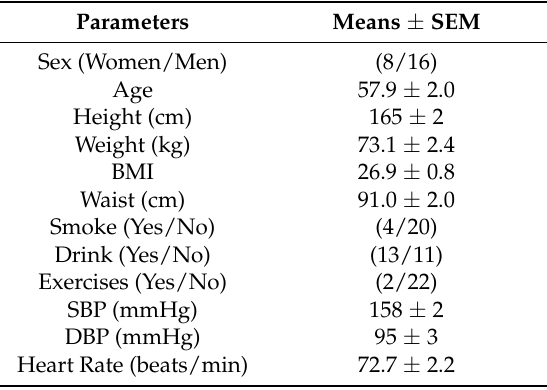
Table 1. Clinical characteristics of all patients at